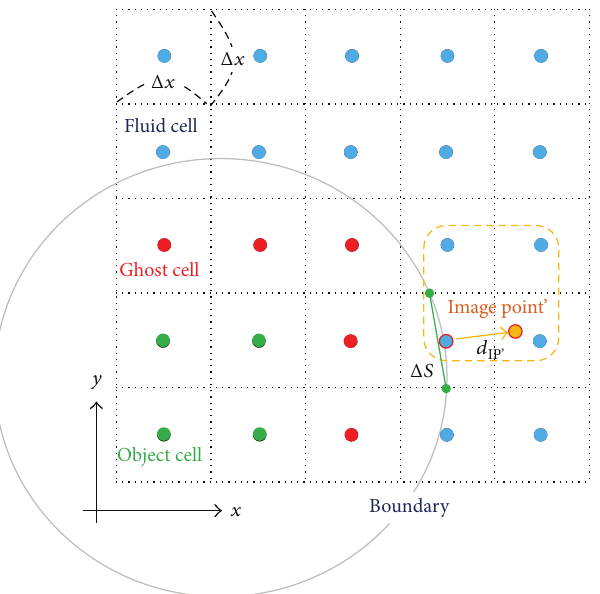
Figure 4: Image point projected from a fluid cell to compute the fluid force on the